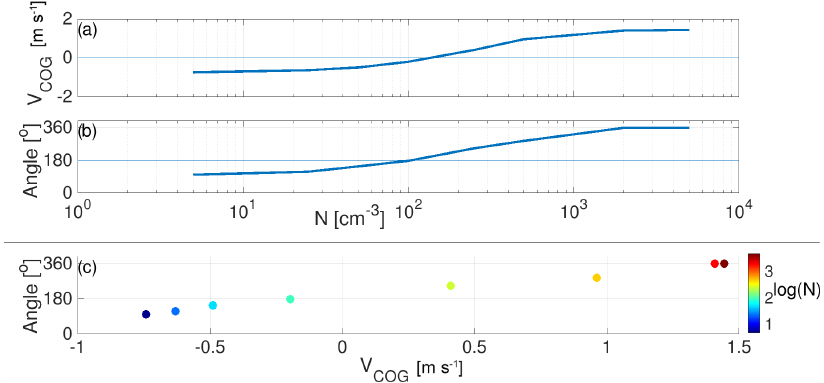
Figure 4. (a) The cloud field’s mean value of V COG and (b) the angle A between the line that connects the first and last thirds of the simulation period and the x axis on the η vs. w phase space for all clouds in the domain (Fig. 3a) as a function of aerosol loading. (c) A vs. V COG . Color coding denotes the different aerosol concentrations ( N [cm − 3 ]).